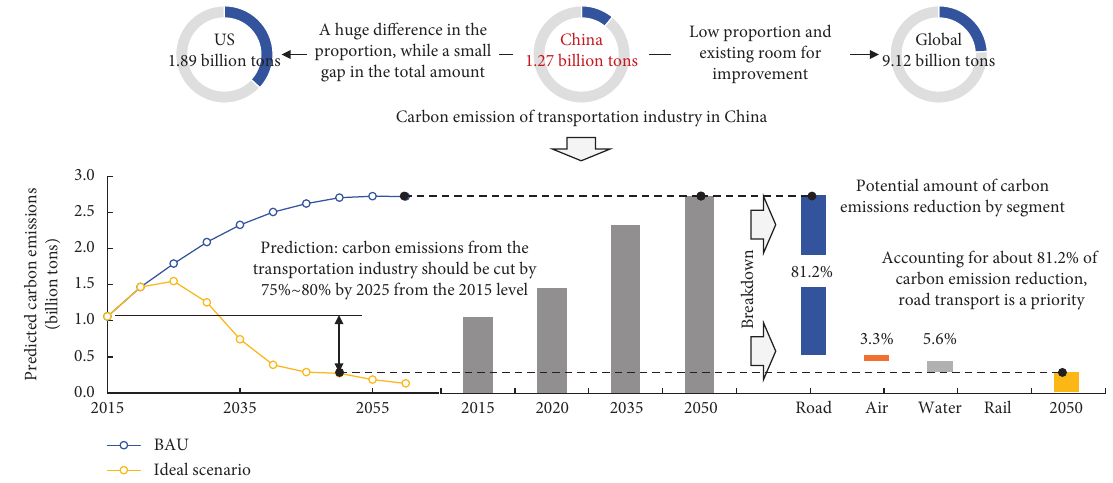
Figure 4: The role of the road transport (automobile industry) sector in achieving the 30 · 60 target in China [4,